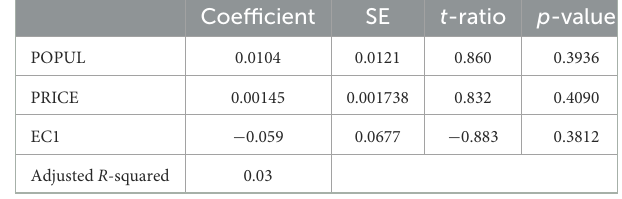
TABLE 8B VECM, VAR(1)—Equation 2: d_PROD.